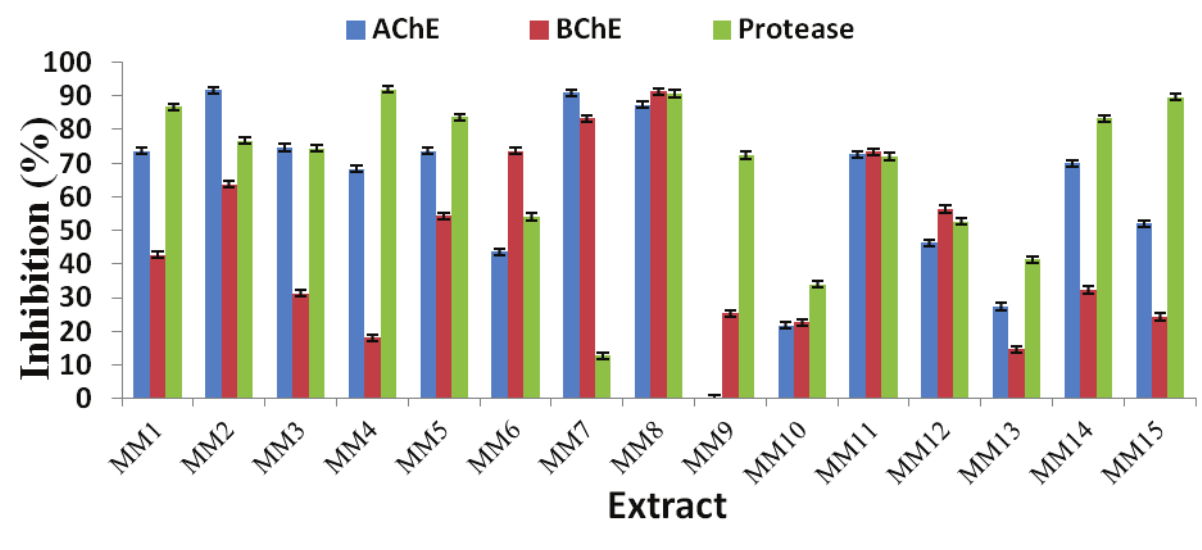
Figure 2: Enzyme inhibition potential of various extracts